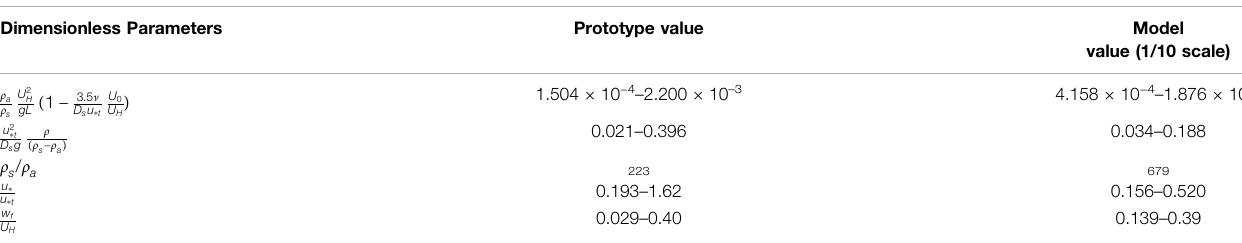
TABLE 6 | Major similarity parameters for the prototype and scale model. Dimensionless